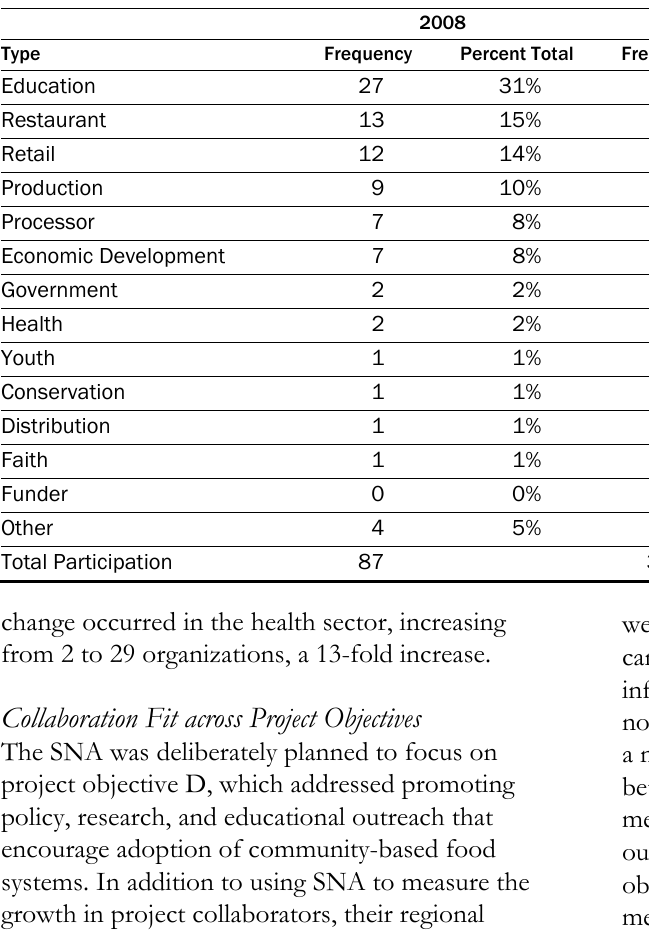
Table 3. Comparison of Collaborating Organizations by Type, 2008 and 2011